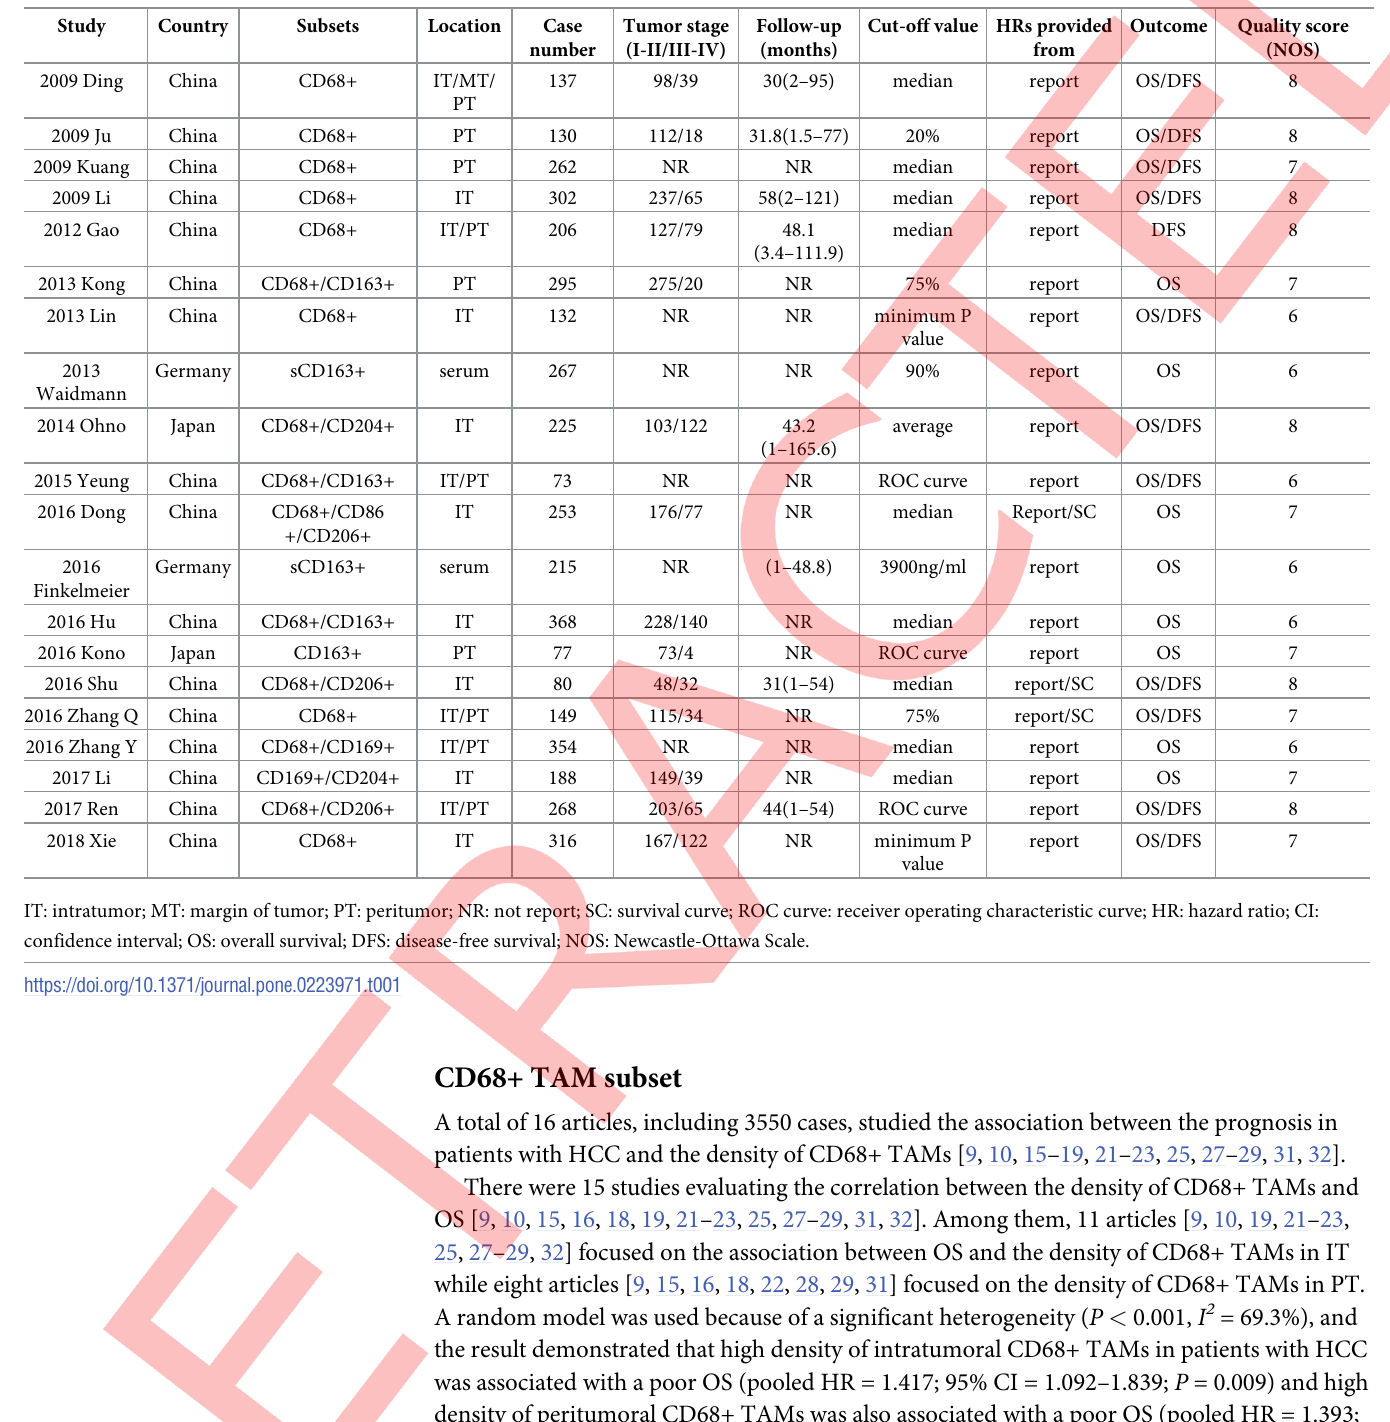
Table 1. Main characteristics of all studies included in the